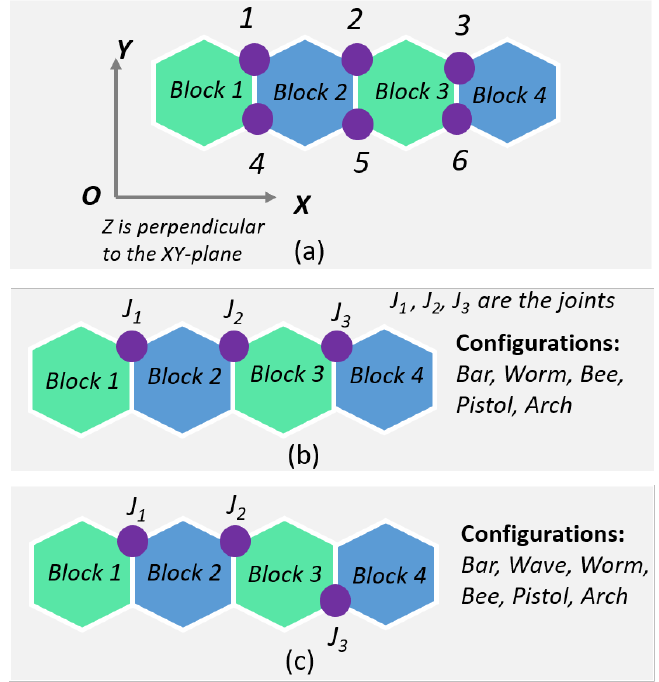
Figure 2. ( a ) Fundamental hinged layout of the robot platform made of polyhex. ( b ) Platform configurations with hinge joint at locations 1, 2, and 3. ( c ) Platform configurations with hinge joint at locations 1, 2, and 6.